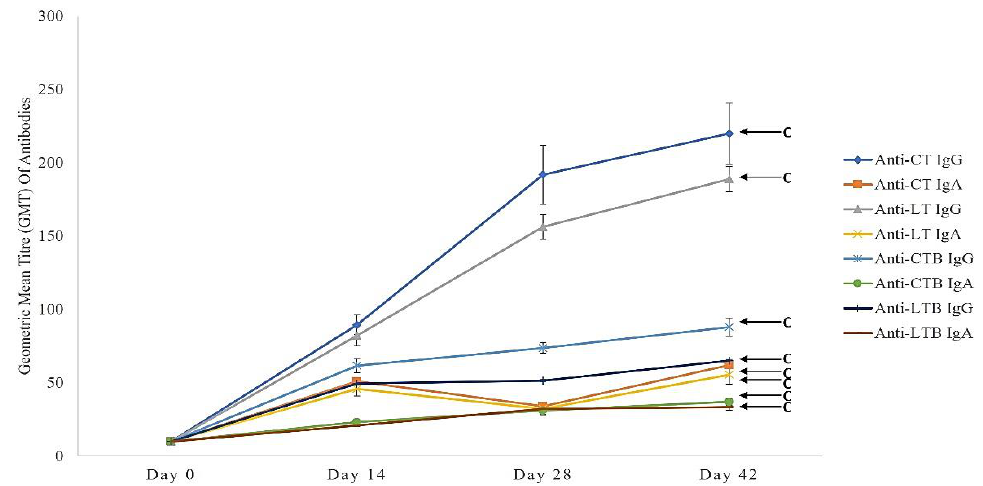
Figure 4. Geometric mean titre (GMT) of anti-CT/CT-B/LT/LT-B IgG, IgA antibodies elicited in immunised mice. All the values are mean ± SEM; n = 6. Significant increase (c p < 0.001) was observed in anti-CT/CT-B/LT/LT-B IgG, IgA antibodies on day 14, 28, and 42 compared with that of day 0. (One-way ANOVA followed by Tukey post hoc test).